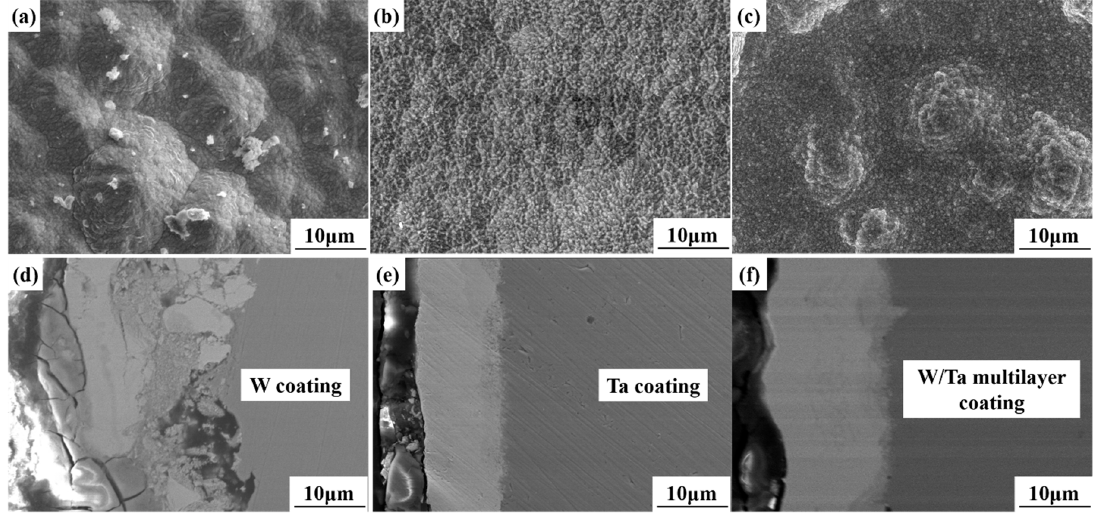
Figure 2. Surface and cross-sectional SEM micrographs of coatings: ( a , d ) W coating, ( b , e ) Ta coating, and ( c , f ) W/Ta multilayer coating.